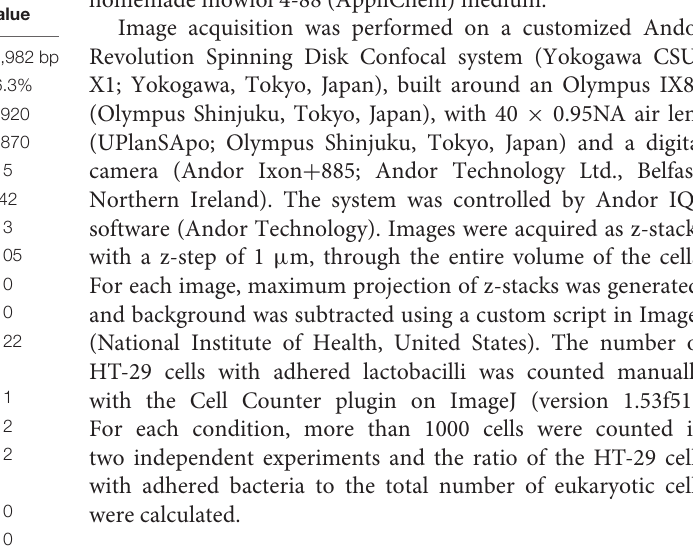
TABLE 1 | Genome characteristics of Lacticaseibacillus paracasei SP5. Genome